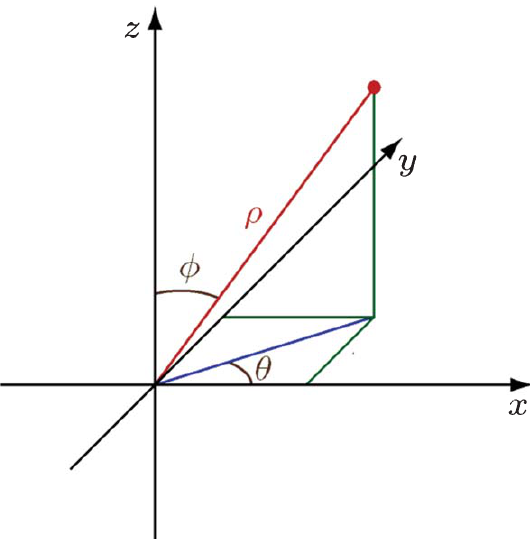
Fig. 4. The coordinate system showing the mean force vector ( ρ ), the colatitude ( φ ) and the azimuth ( θ )